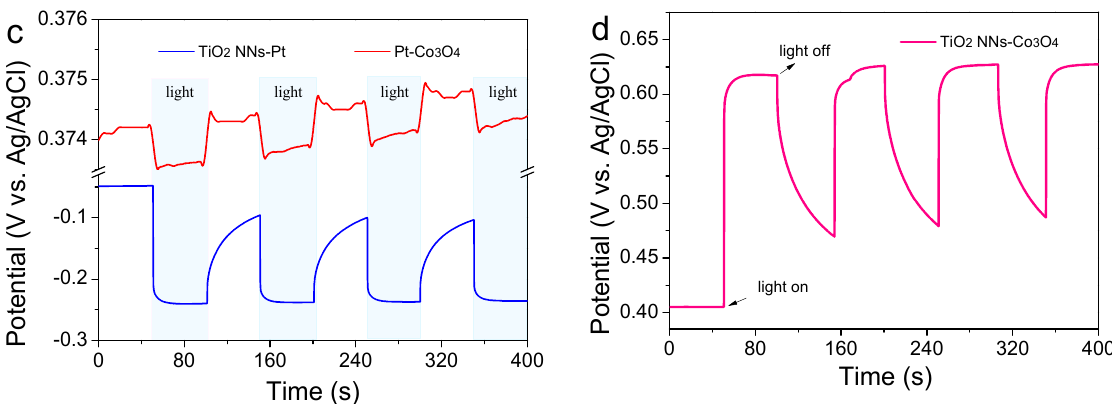
Figure 4. ( a ) Transient photocurrent responses of TiO 2 NNs-Pt, Pt-Co 3 O 4 , and TiO 2 NNs-Co 3 O 4 . ( b ) EIS Nyquist plots with or without light irradiation. The Voc of ( c ) TiO 2 NNs-Pt and Pt-Co 3 O 4 PEC system in the dark and under LED light illumination, and ( d ) TiO 2 NNs-Co 3 O 4 PEC system. To further clarify the peculiarity of the novel TiO 2 NNs-Co 3 O 4 system, we measured the open-circuit voltage (Voc) of different PEC systems (Figure 4c,d). Notably, the V